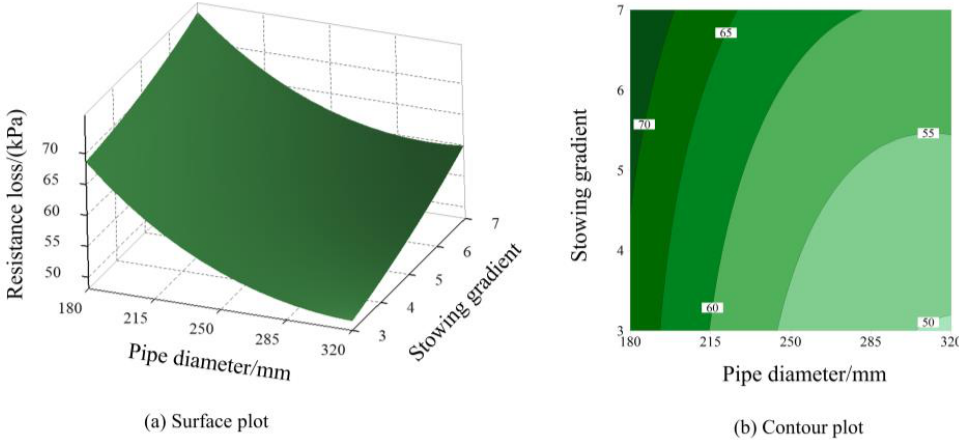
Figure 12. Interaction of pipe diameter and stowing gradient with resistance loss: the other factor is held at the center level.